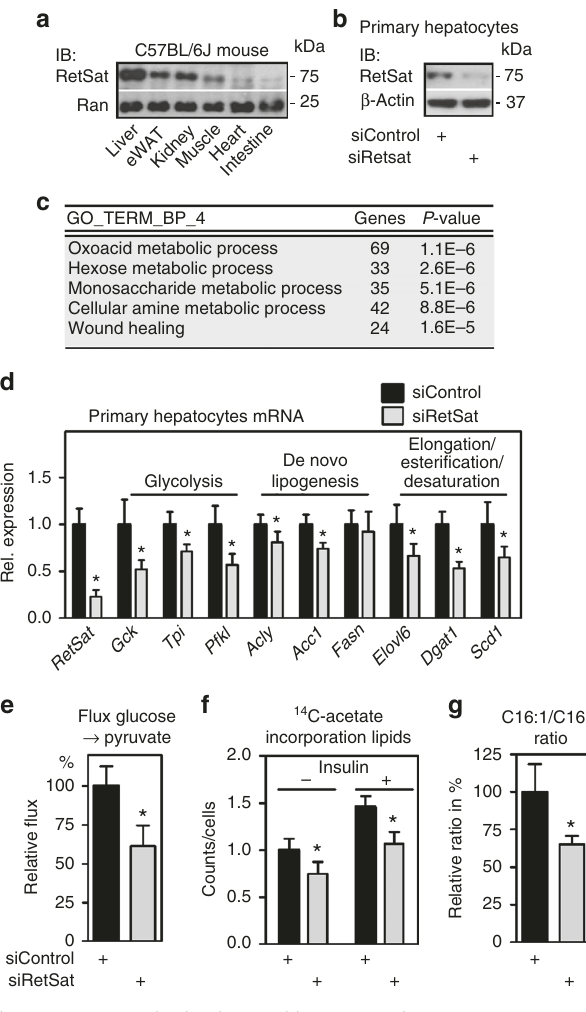
Fig. 1 RetSat controls glycolytic and lipogenic pathways in primary hepatocytes. a RetSat protein expression in metabolically relevant mouse tissues was analyzed by immunoblotting. b RetSat protein expression, 48 h after transfecting Control or RetSat siRNA, was determined by immunoblotting. c Top fi ve enriched pathways of genes that are regulated by RetSat depletion in hepatocytes were identi fi ed by DAVID functional annotation of Affymetrix gene expression pro fi les. d mRNA expression of selected genes in siControl or siRetSat hepatocytes was determined by qPCR. Data are shown as mean ± s.d., n = 6 independent transfections of hepatocyte cultures from two mice; * P < 0.05 by two-tailed t -test. An independent experiments yielded similar results. e Hepatocytes depleted of RetSat were incubated with 13 C-glucose for 5 min and 13 C-pyruvate labelling analyzed by mass spectroscopy. Data are shown as mean ± s.d., n = 4 independent transfections of hepatocyte cultures from the same mouse; * P < 0.05 by two-tailed t -test. An independent experiment yielded similar results. f Incorporation of 14 C-acetate into extractable lipids was assessed in hepatocytes treated as indicated. Data are shown as mean ± s.d., n = 6 independent transfections of hepatocyte cultures from the same mouse; signi fi cance between siControl and siRetSat was tested by two-tailed t- test and * P < 0.05. An independent experiment yielded similar results. g Palmitate/palmitoleate ratio in siControl- or siRetSat-treated hepatocytes was assessed by mass spectroscopy. Data are shown as mean ± s.d., n = 4 independent transfections of hepatocyte cultures from the same mouse; * P < 0.05 by two-tailed t -test. An